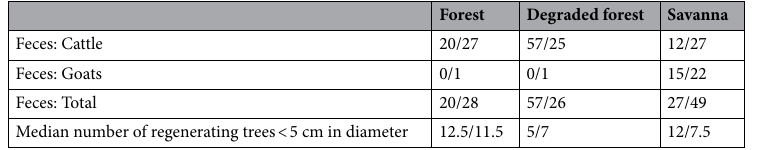
Table 2. Livestock feces recorded along two transects and median number of regenerating trees < 5 cm in diameter per 2 × 2 m 2 vegetation plot in three different vegetation formations in Oronjia, Madagascar. The values for the two transects are separated by